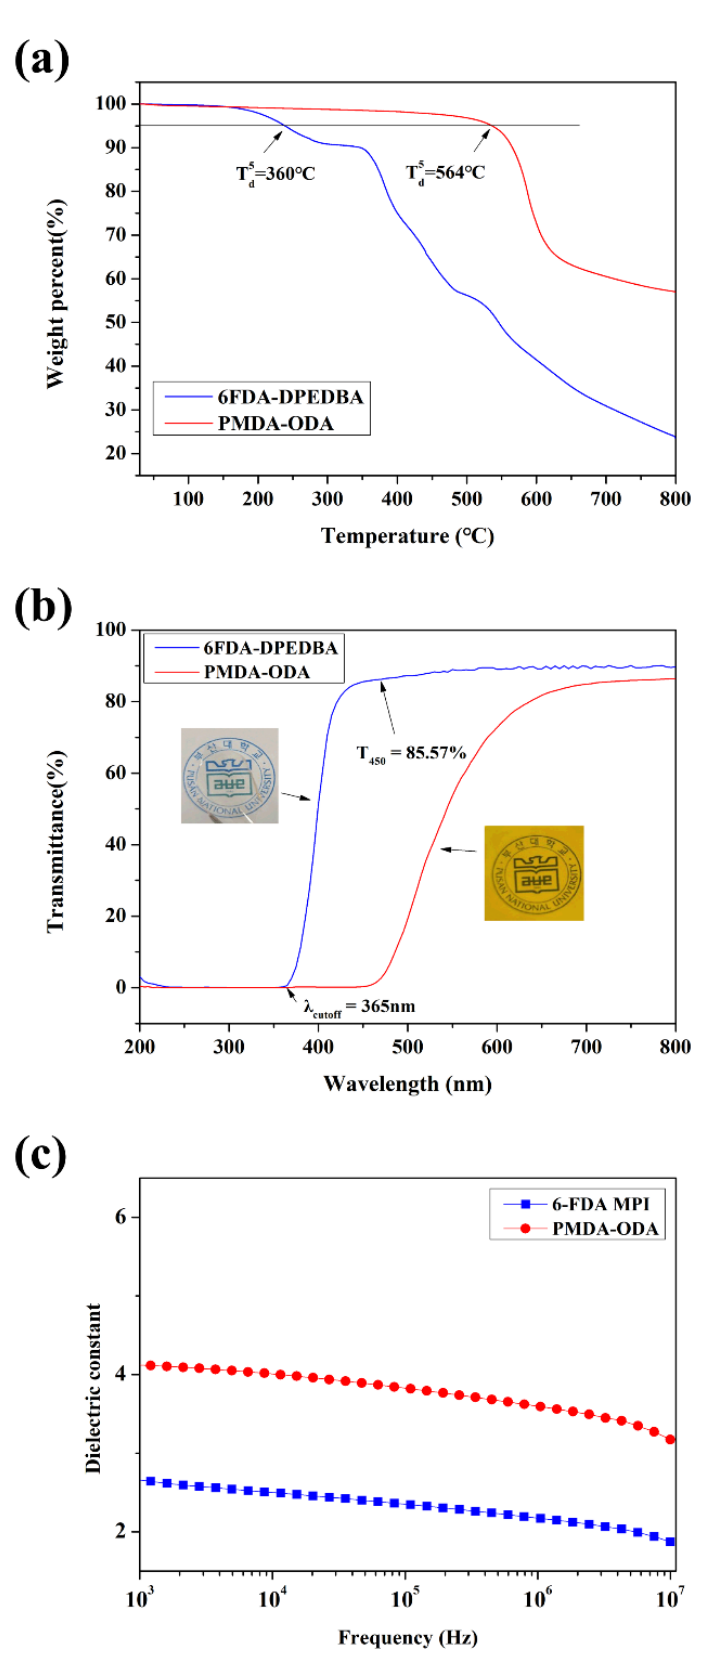
Figure 7. TGA curves ( a ), UV–Visible spectra ( b ), and dielectric constants ( c ) of the 6FDA-DPEDBA PI film and PMDA-ODA PI film.